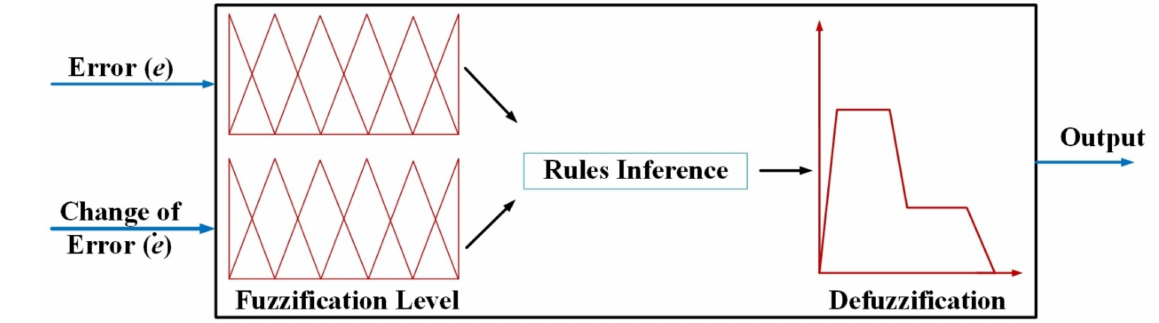
Figure 3. The FLC structure.